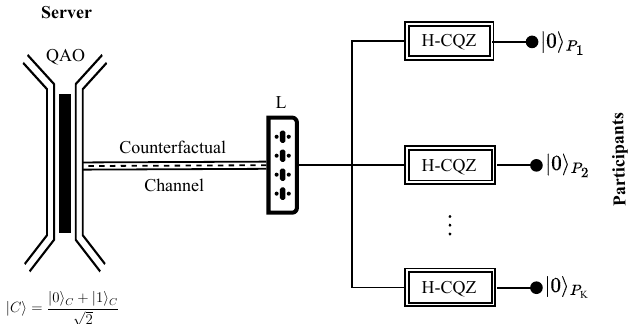
= | 0 (cid:105) C + | 1 (cid:105) C C while the K participants 2 | (cid:105) 0 where i 1,2,..., K . Each participant performs an | (cid:105) P i ∈ { }